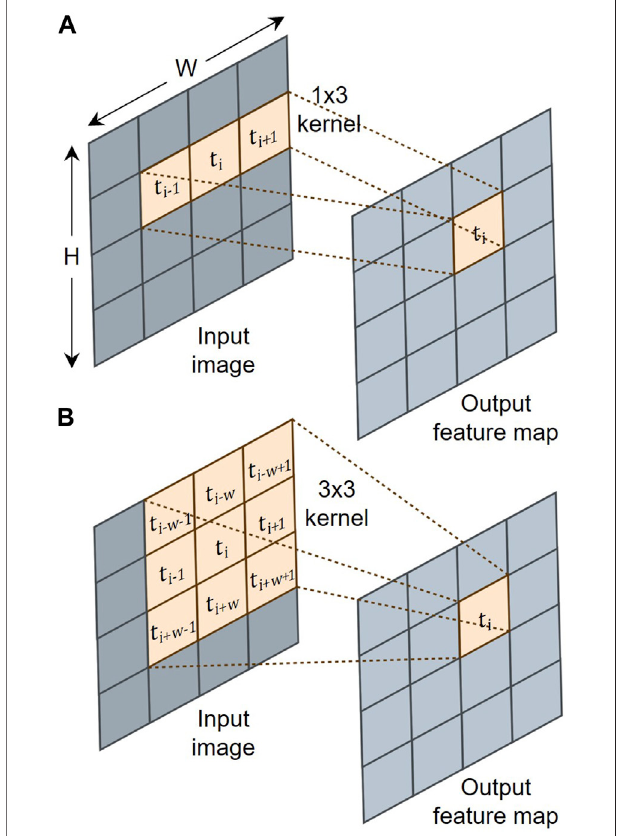
FIGURE 5 | Effect of kernel size and the image width on the output feature map for (A) 1D and (B) 2D